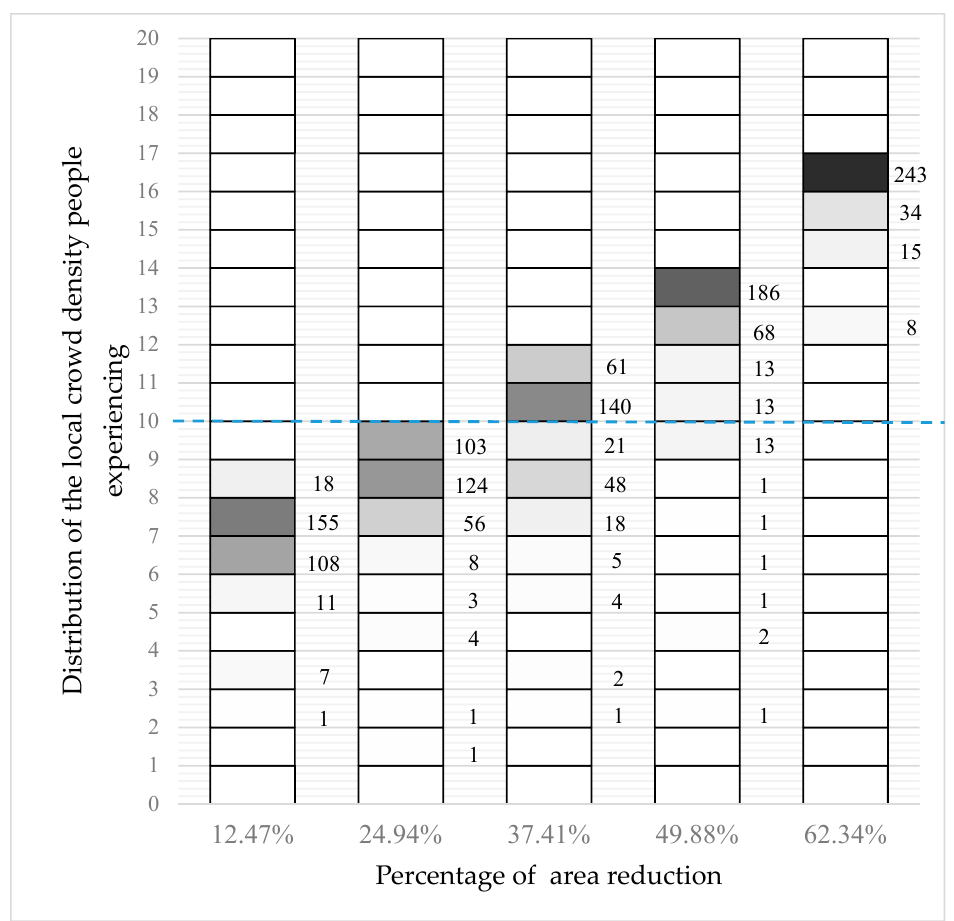
Figure 8. A total of 300 agents are packed hexagonally with three fixed walls, while the wall at the bottom moves upwards in the simulation.